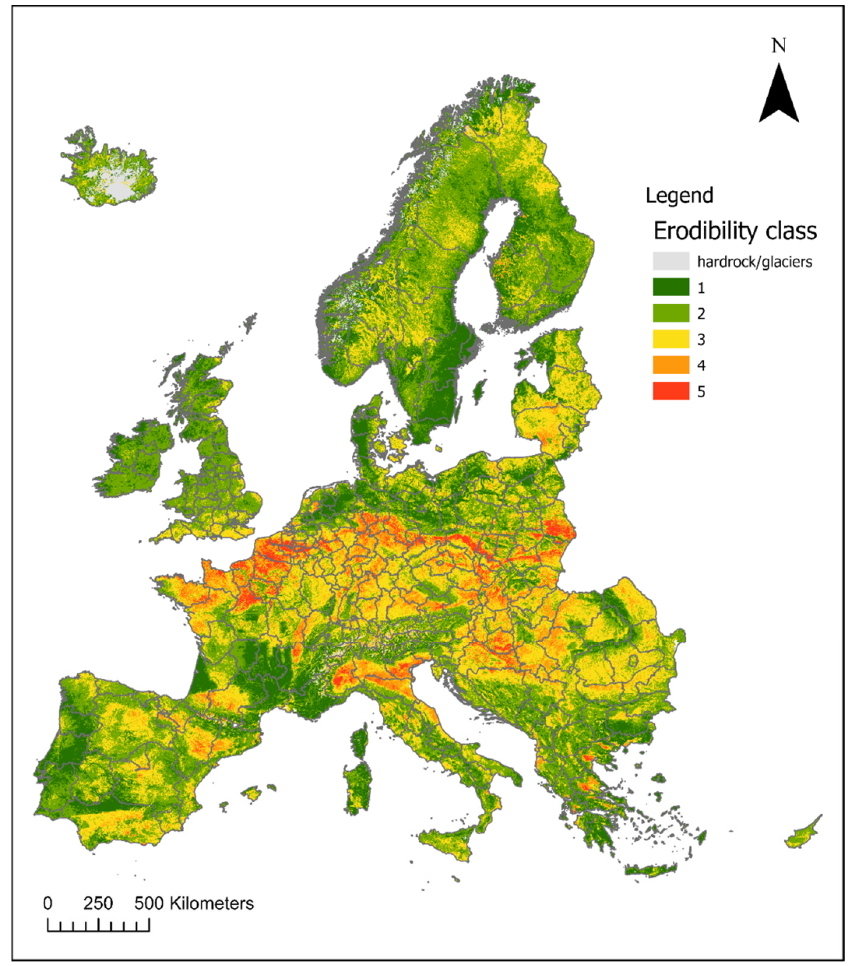
Figure 5. Erodibility map as used in SoilCare. Note that bare rock and glacier areas (according to CLC2018) were excluded (grey colours).